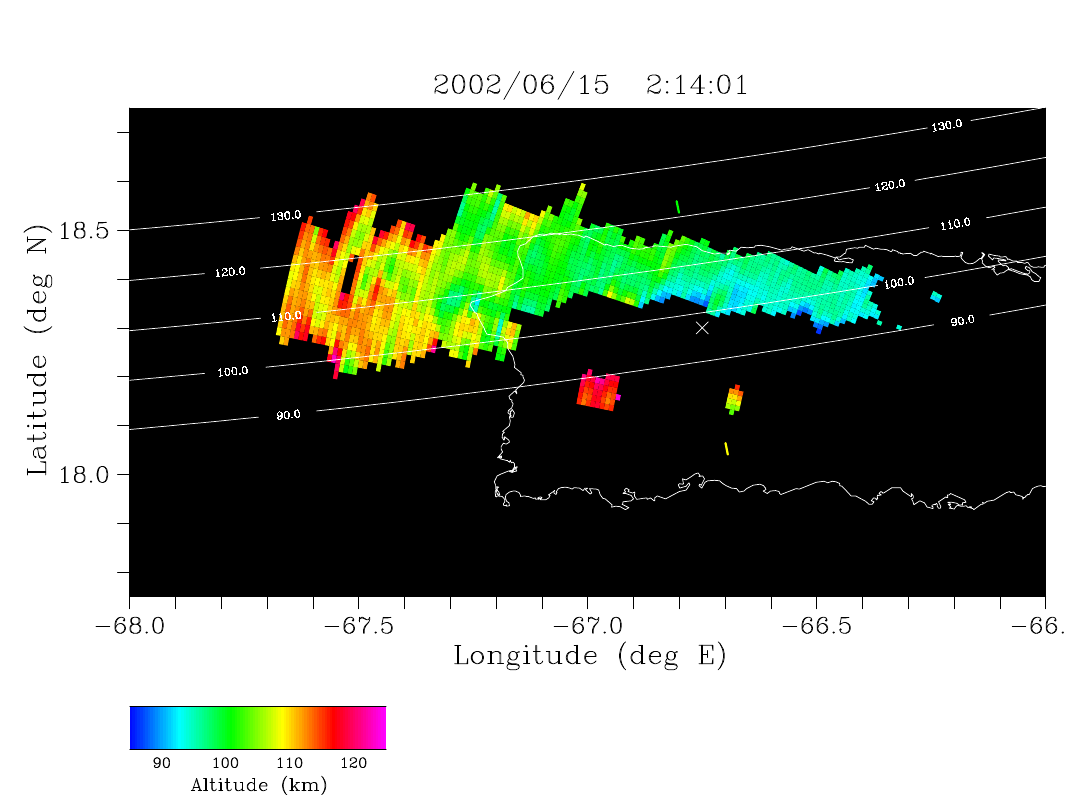
Fig. 13. Representation of the centroid altitude of the backscatter shown in the previous